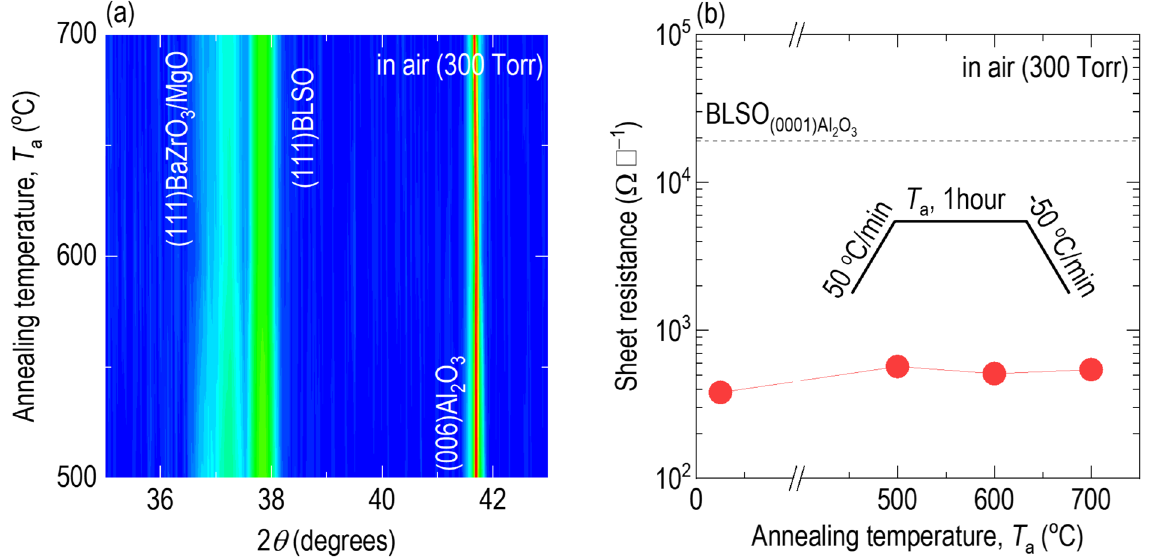
Fig. 6 Thermal stability of BLSO BaZrO 3 / MgO ( 0001 ) Al . After annealing in air, even at 700 °C (inset), the a XRD θ–2θ scan and b sheet resistance of the as-grown 2 O 3 films are